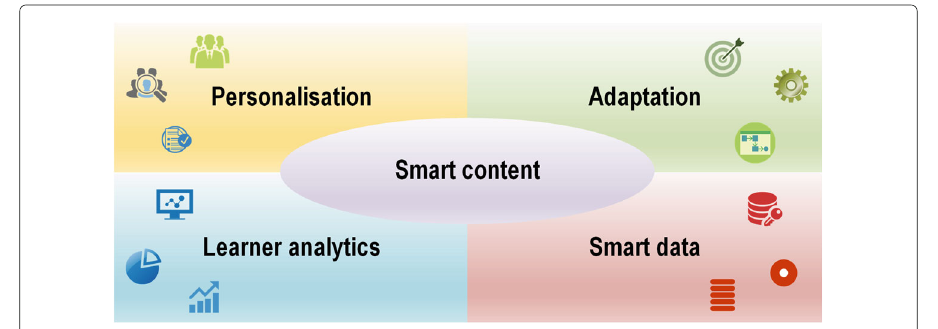
Fig. 1 Learning in smart environment